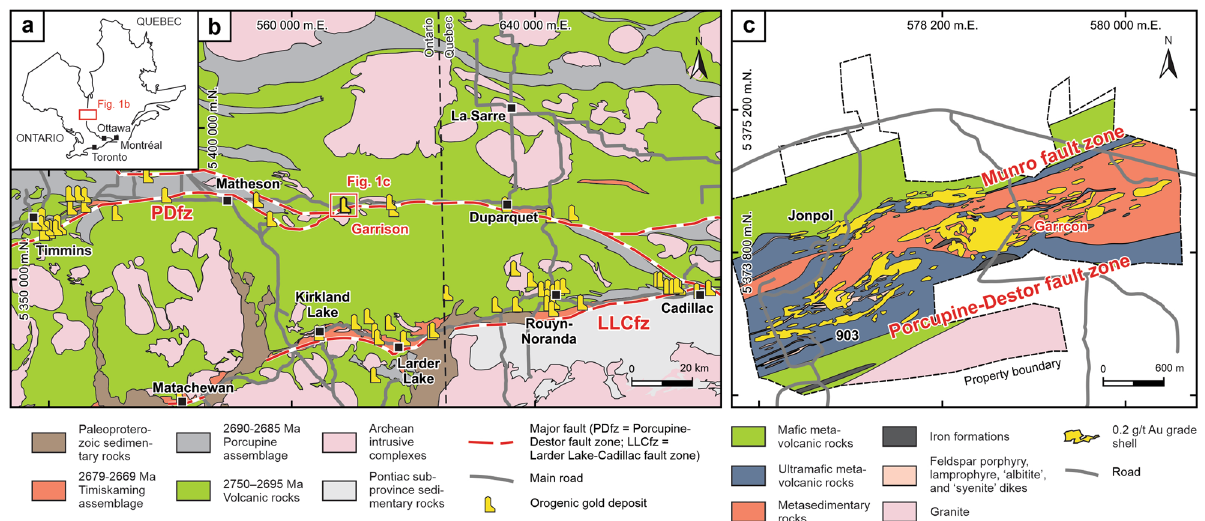
Figure 1. Geological setting of the Garrcon deposit. ( a ) Location in the Superior Province. ( b ) Map of the southern Abitibi greenstone belt showing major fault zones and locations of orogenic gold deposits along the Porcupine-Destor and Larder Lake-Cadillac fault zones. Map modified from Ref. 22 . ( c ) Geology of the Garrison gold camp and the Garrcon deposit. Map modified from Ref. 31 . Figure was created using CorelDRAW ® 2021 (https:// www. corel draw.